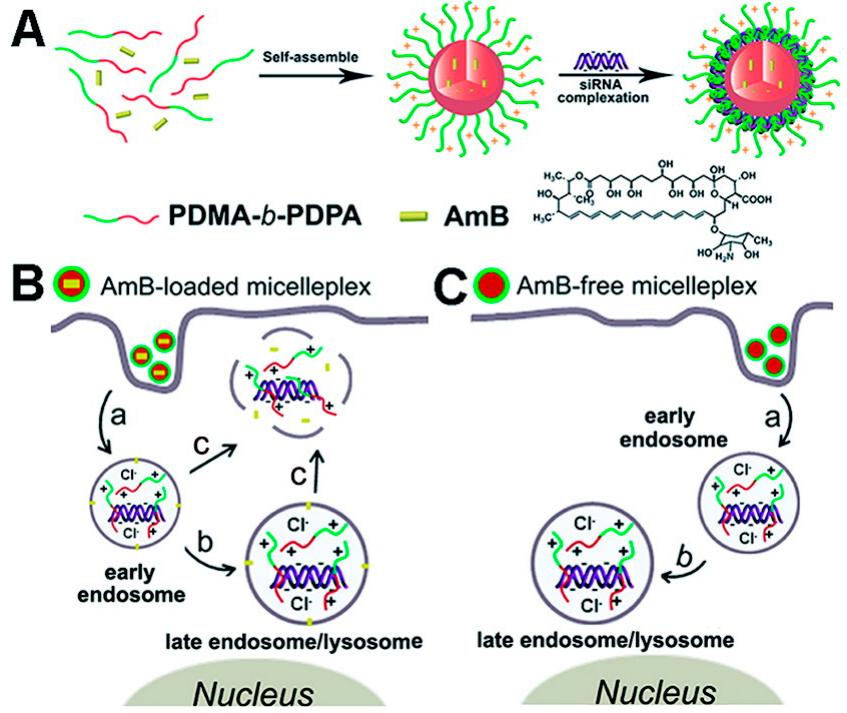
Figure 4. Schematic diagram of AmB-loaded dual pH-responsive micelleplexes for siRNA delivery with enhanced siRNA endosomal escape ability. ( A ) Production of AmBloaded PDMA-b-PDPA micelleplexes. AmB was loaded in the hydrophobic PDPA core, and siRNA was complexed with the PDMA corona shell. ( B ) AmB-facilitated endosome disruption and siRNA cytoplasmic release (a: AmB-loaded micelleplexes dissociated in early endosomes after cell uptake, and AmB molecules are inserted into endosomal membranes; b: protonated PDMA-b-PDPA unimers complexed with siRNA and trafficked from early endosomes into late endosome/lysosomes, causing vesicle swelling; c: AmB-enhanced siRNA release from endosomes into cytoplasm via membrane destabilization). ( C ) In the case of AmB-free micelleplexes, polymer/siRNA complexes were entrapped in late endosomes or lysosomes without efficient cytoplasmic siRNA release. Reproduced from ref. [130] with permission from the American Chemical Society.